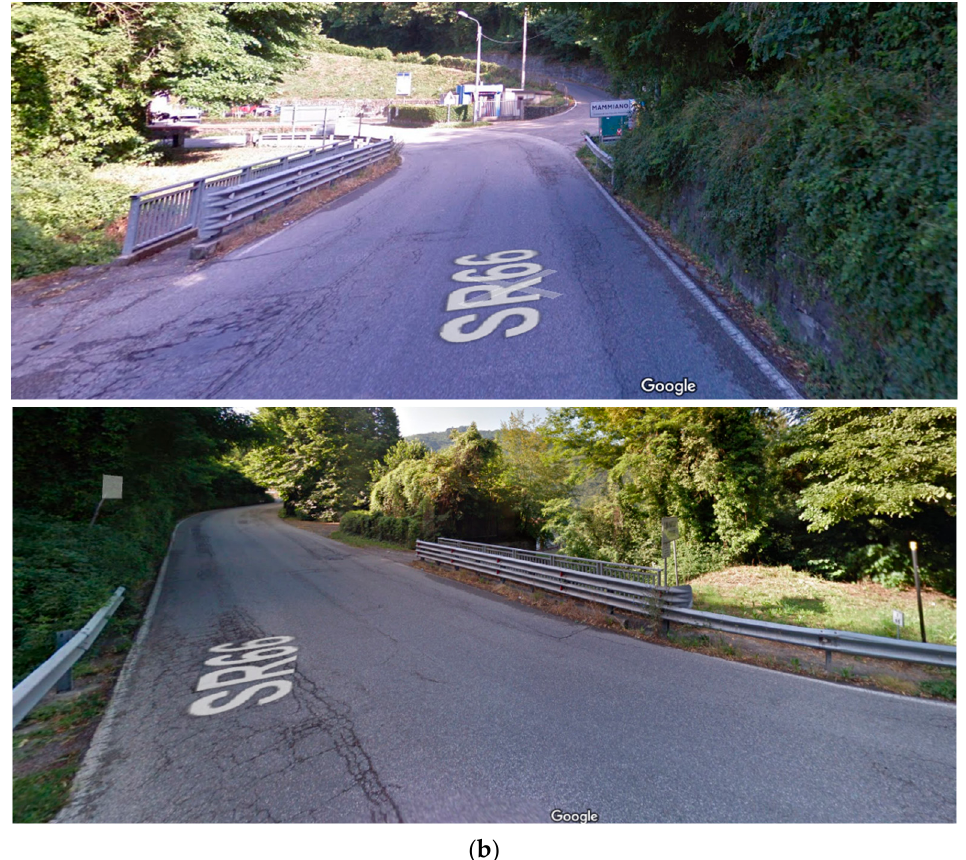
( b ) Figure A11 . 3rd Case study, Road SR66_Nord: ( a ) in 2011; ( b ) in 2019. Figure A11. 3rd Case study, Road SR66_Nord: ( a ) in 2011; ( b ) in